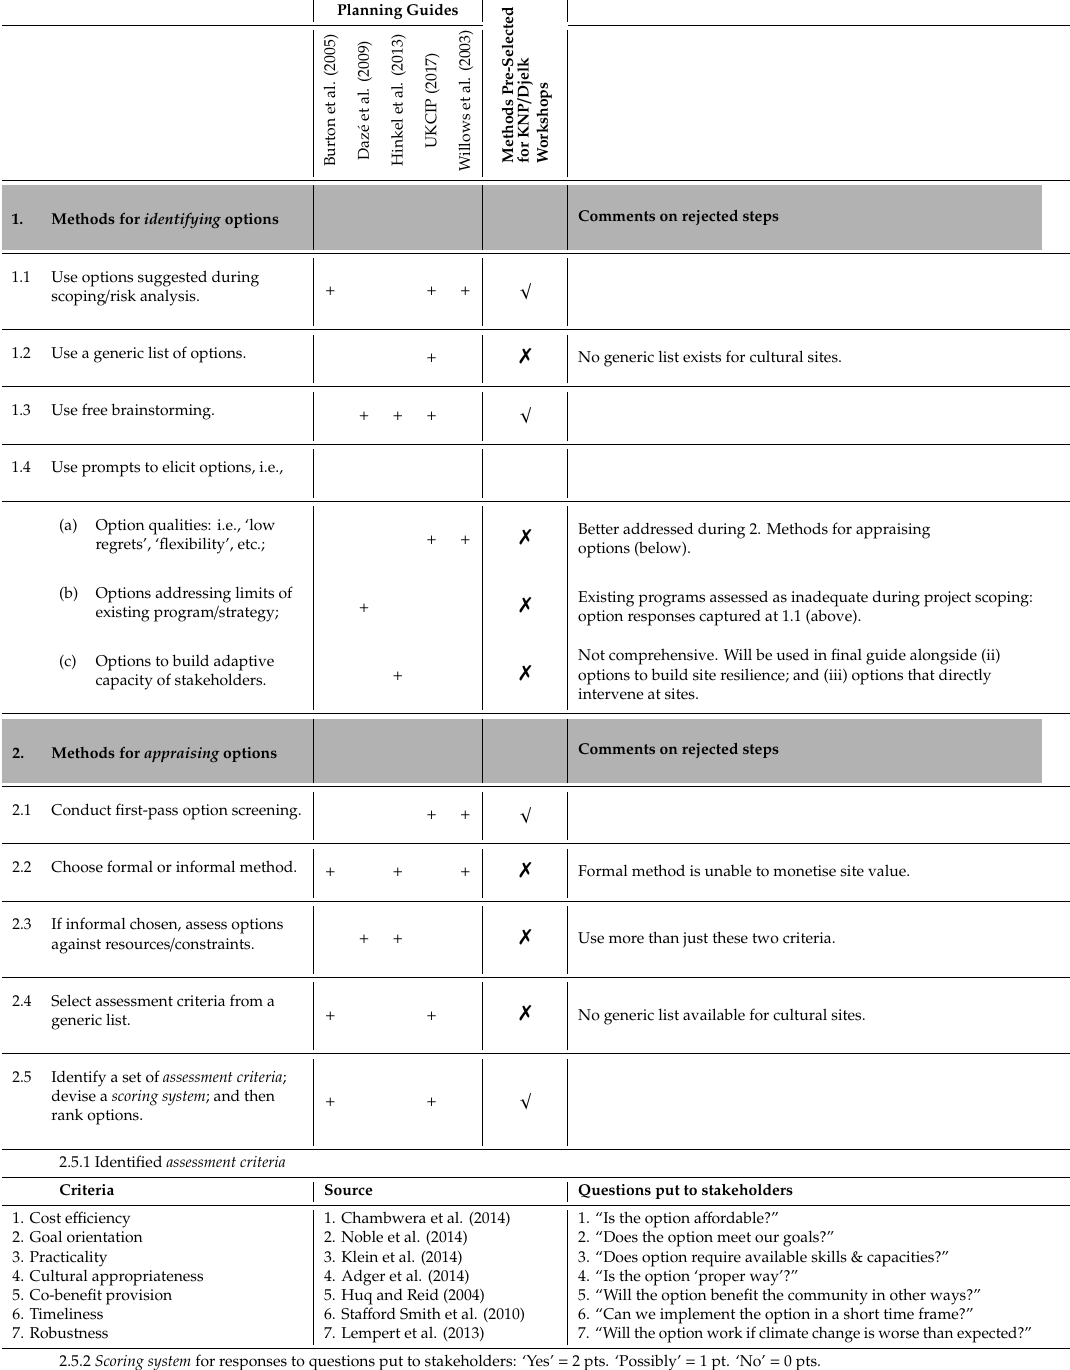
Table 1. Comparison and selection of options-analysis methods.